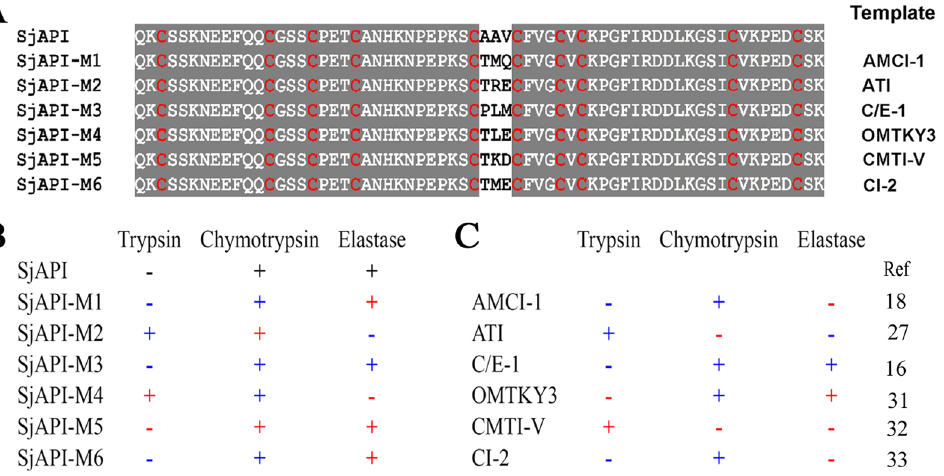
Figure 7. The six designed chimeras that transfer the active sites of different peptides from Ascaris , Kazal, and potato I family folds. (A) Amino acid sequence alignments of six chimeras and SjAPI. SjAPI-M1 was from the Ascaris -type peptide AMCI-1, SjAPI-M2 was from the Ascaris - type peptide ATI, SjAPI-M3 was from the Ascaris -type peptide C/E-1, SjAPI-M4 was from the Kazal-type peptide OMTKY3, SjAPI-M5 was from the potato I family peptide CMTI-V, and SjAPI-M6 was from the potato I family peptide CI-2. (B) Comparison of the serine protease inhibitory activity profiles of six chimeras with those of their templates and SjAPI.